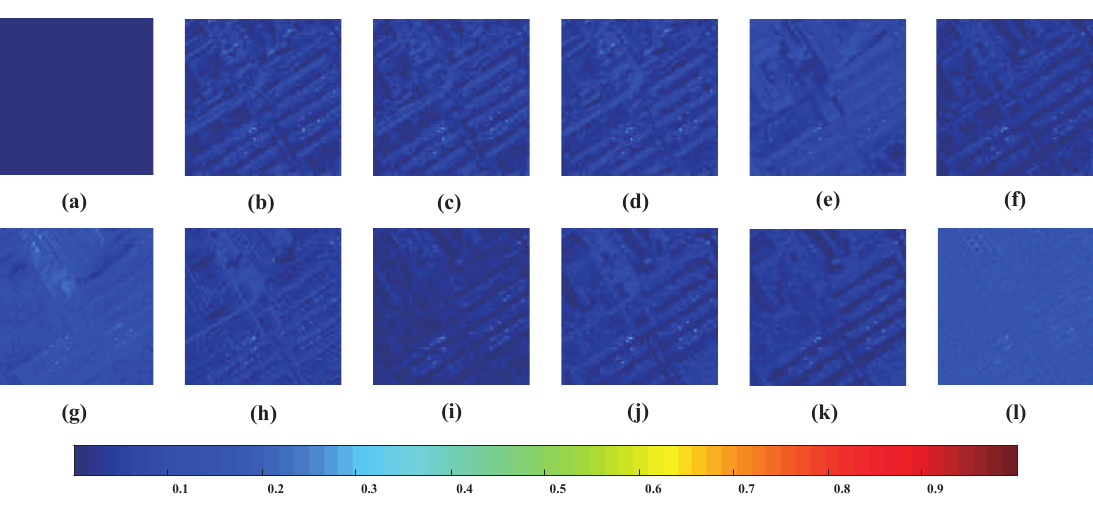
Figure 10. Absolute difference maps between the pansharpened results and the reference one obtained by different methods on the University of Pavia data set: ( a ) reference, ( b ) SFIM, ( c )